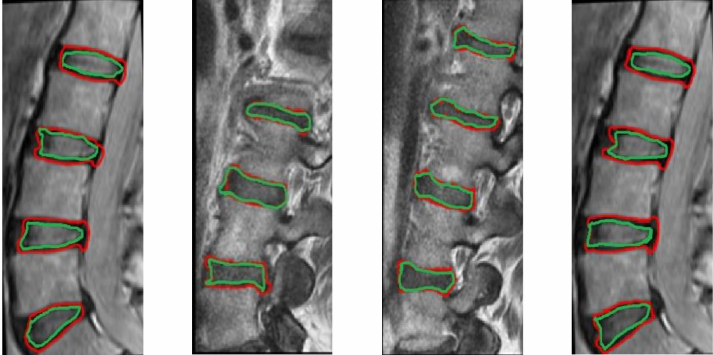
Figure 11. Segmentation results from our automatic method, illustration CT images from di ff erent data with red color. The ground truth contours are described with green color.